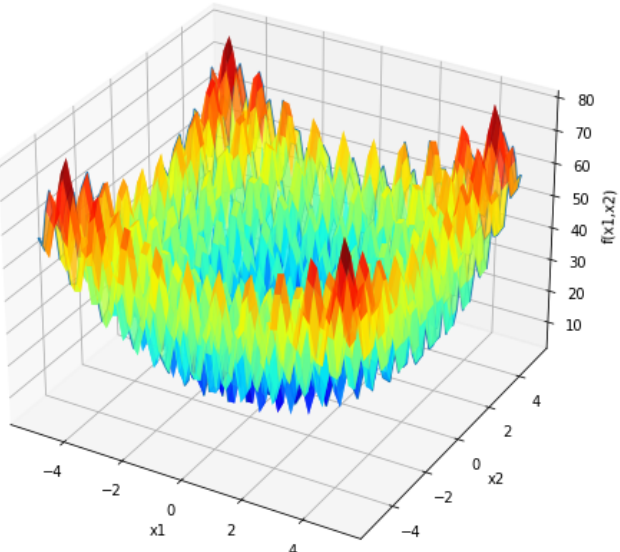
Figure 8. Surface plot of the Rastrigin function.